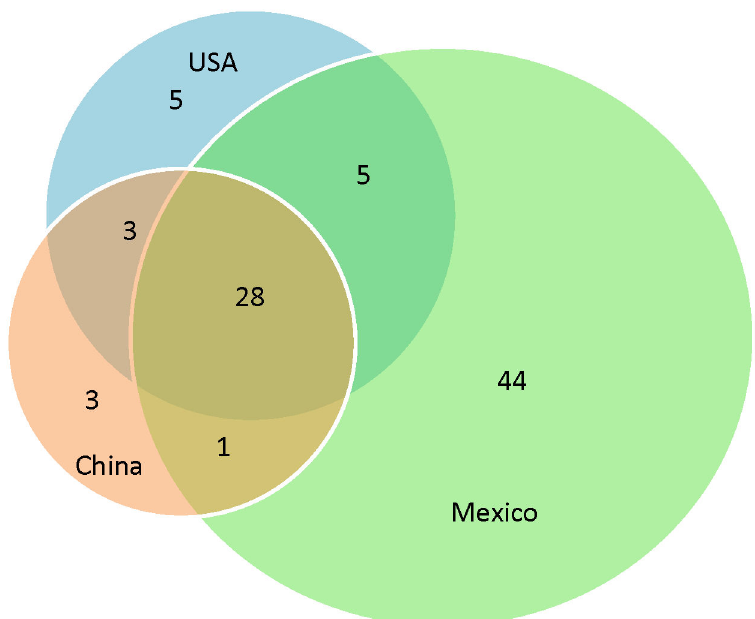
Figure 2. Venn diagram of the distribution of all distinct alleles across loci for the three geographic regions studied: Mexico, the U.S.A. and China. Overlapping areas (intersections) denote shared alleles between two or three regions. doi: